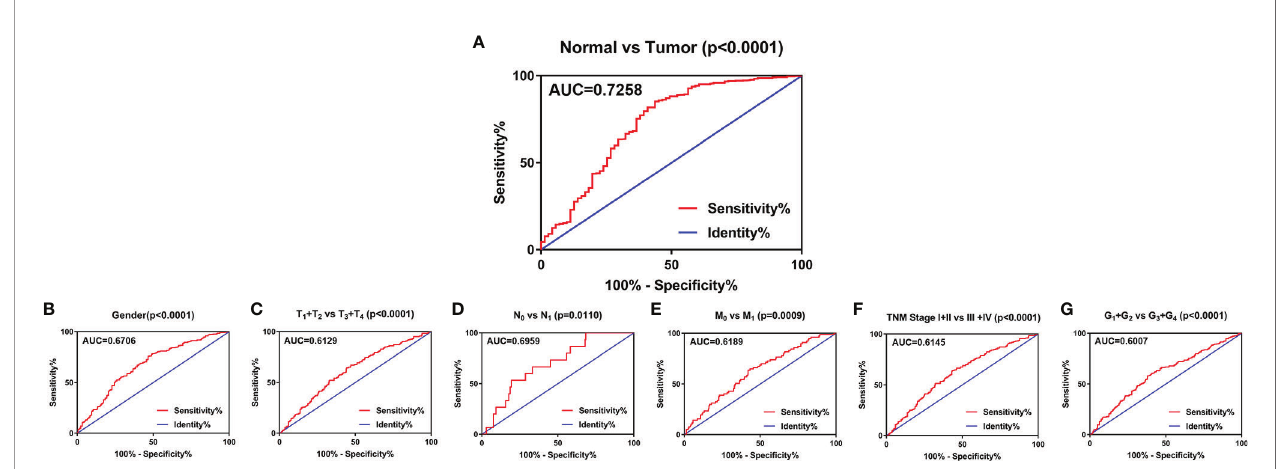
FIGURE 4 | SLC22A12 expression may be a diagnostic predictor in patients with ccRCC. (A) SLC22A12 effectively discriminated between ccRCC and normal tissues. Receiver operating characteristic curve subanalysis were performed for the following subgroups of patients with ccRCC: (B) gender, (C) T stage, (D) N stage, (E) M stage, (F) AJCC clinical stage, (G) G stage. AUC, area under curve; OS, overall survival; DFS, disease-free